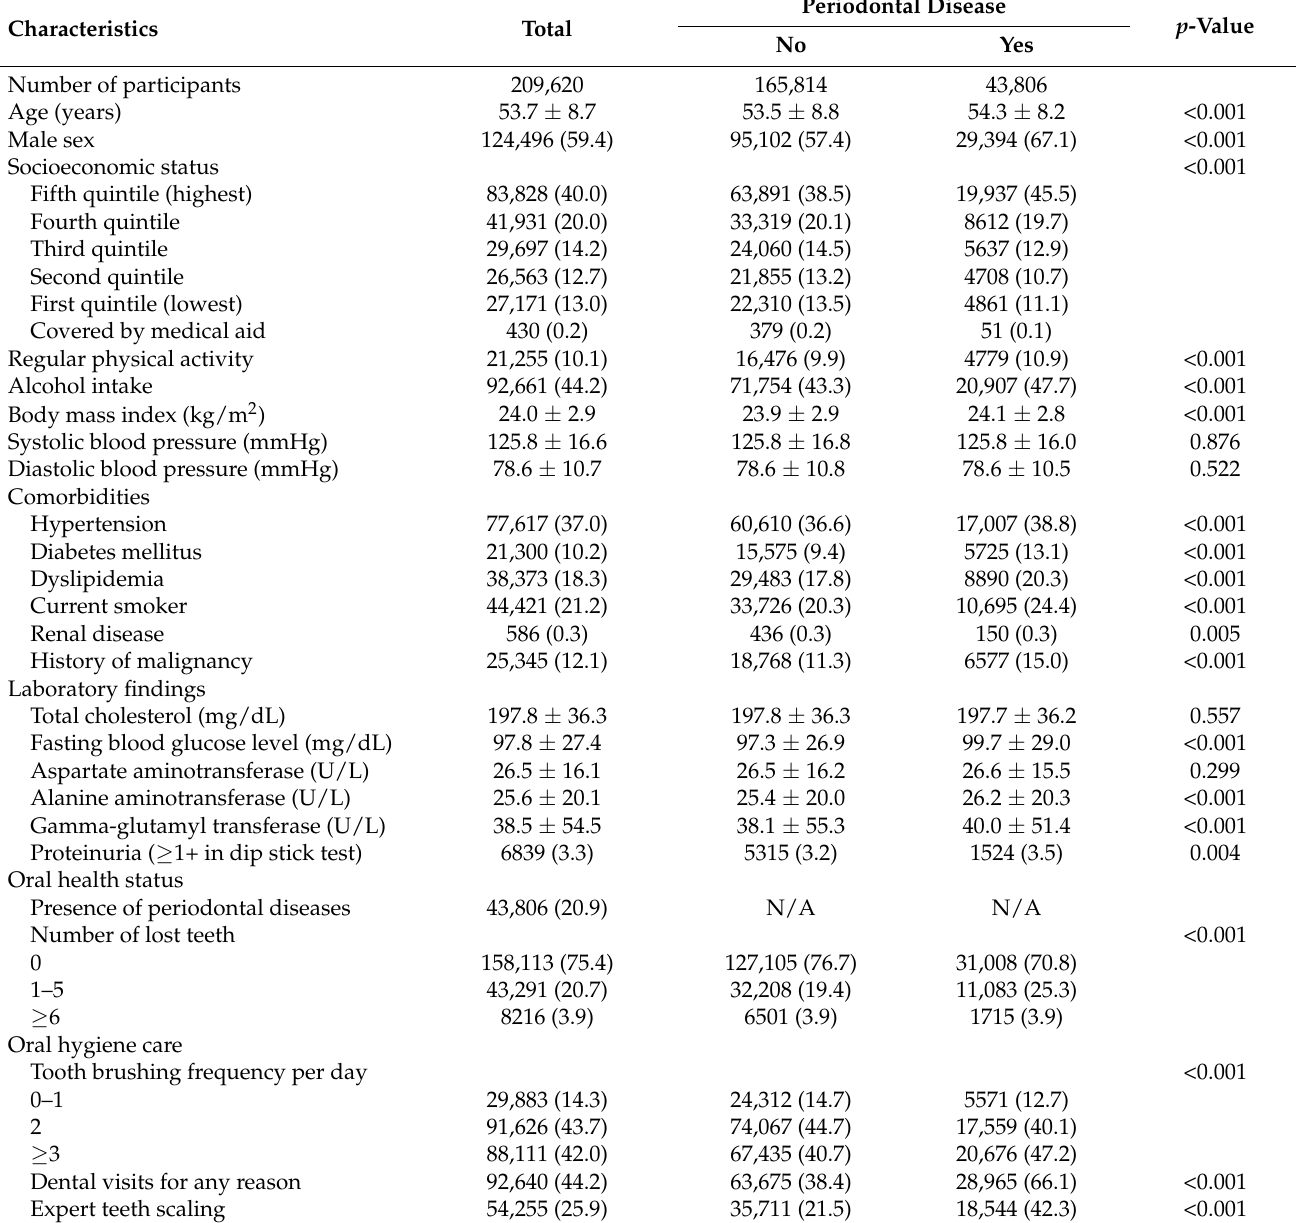
Table 1. Baseline characteristics between participants with and without periodontal